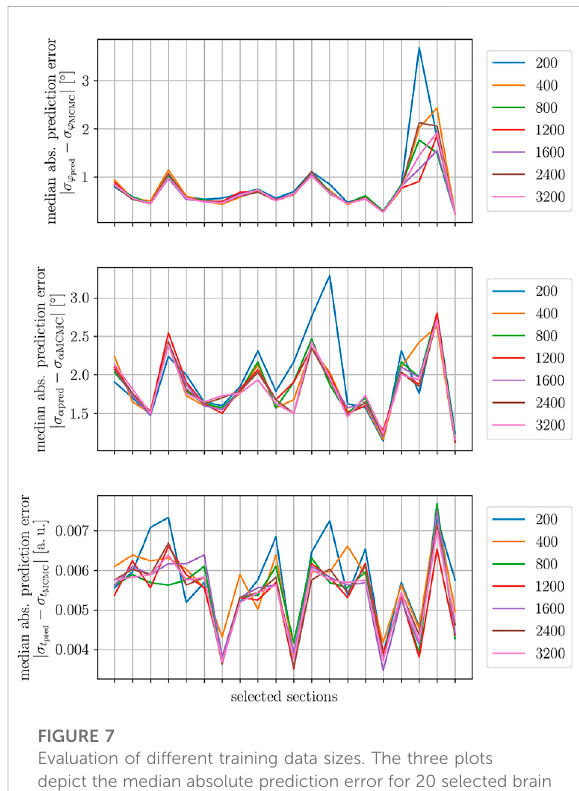
FIGURE 7 Evaluation of different training data sizes. The three plots depict the median absolute prediction error for 20 selected brain sections. Top: In-plane angle uncertainty prediction error. Middle: Out-of-plane angle uncertainty prediction error. Bottom: Relative thickness uncertainty prediction